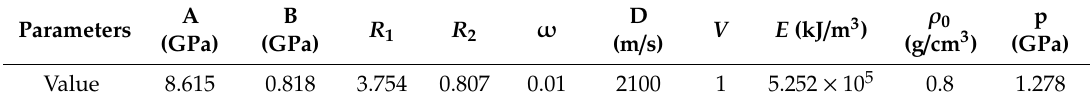
Table 1. The parameters of the Jones – Wilkins – Lee (JWL) equation and physical parameters.